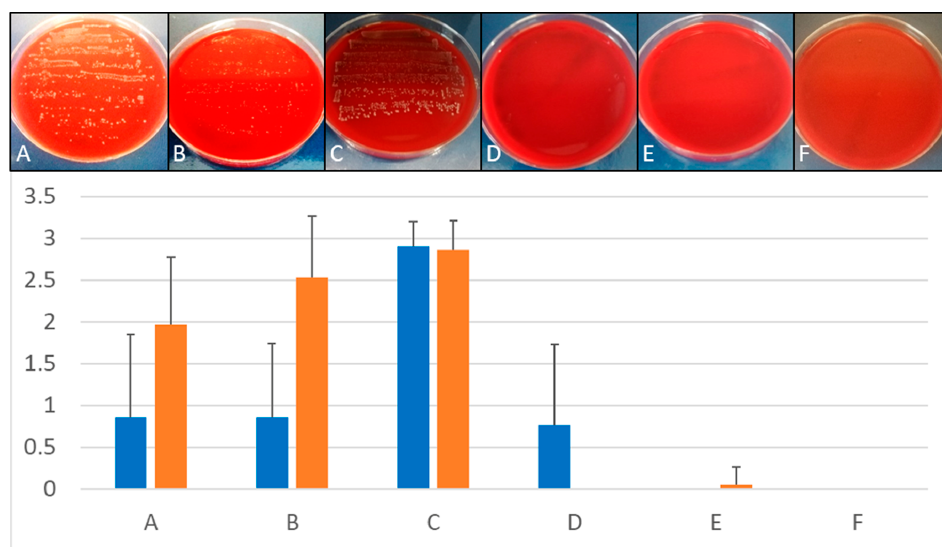
Figure 6. Treatment of C. dubliniensis biofilms. Upper panel: Comparison of growth on Columbia Blood Agar plates after different treatment of implants infected with C. dubliniensis and placed in silicone. Lower panel: Quantitative comparison of growth on implants inserted in silicone (blue bars) and polyurethane foam (orange) depending on treatment protocols. ( A ) Mechanical debridement, ( B ) air abrasion, ( C ) BDD treatment for 0 min, ( D ) BDD treatment for 5 min, ( E ) BDD treatment for 10 min, ( F ) BDD treatment for 15 min ( n = 3 for each methods and time point). Growth of implant roll-outs was rated from 0 (no growth) to 3 (strong growth). Columns represent the mean of 3 independent biological replicated ± standard deviation (SD).